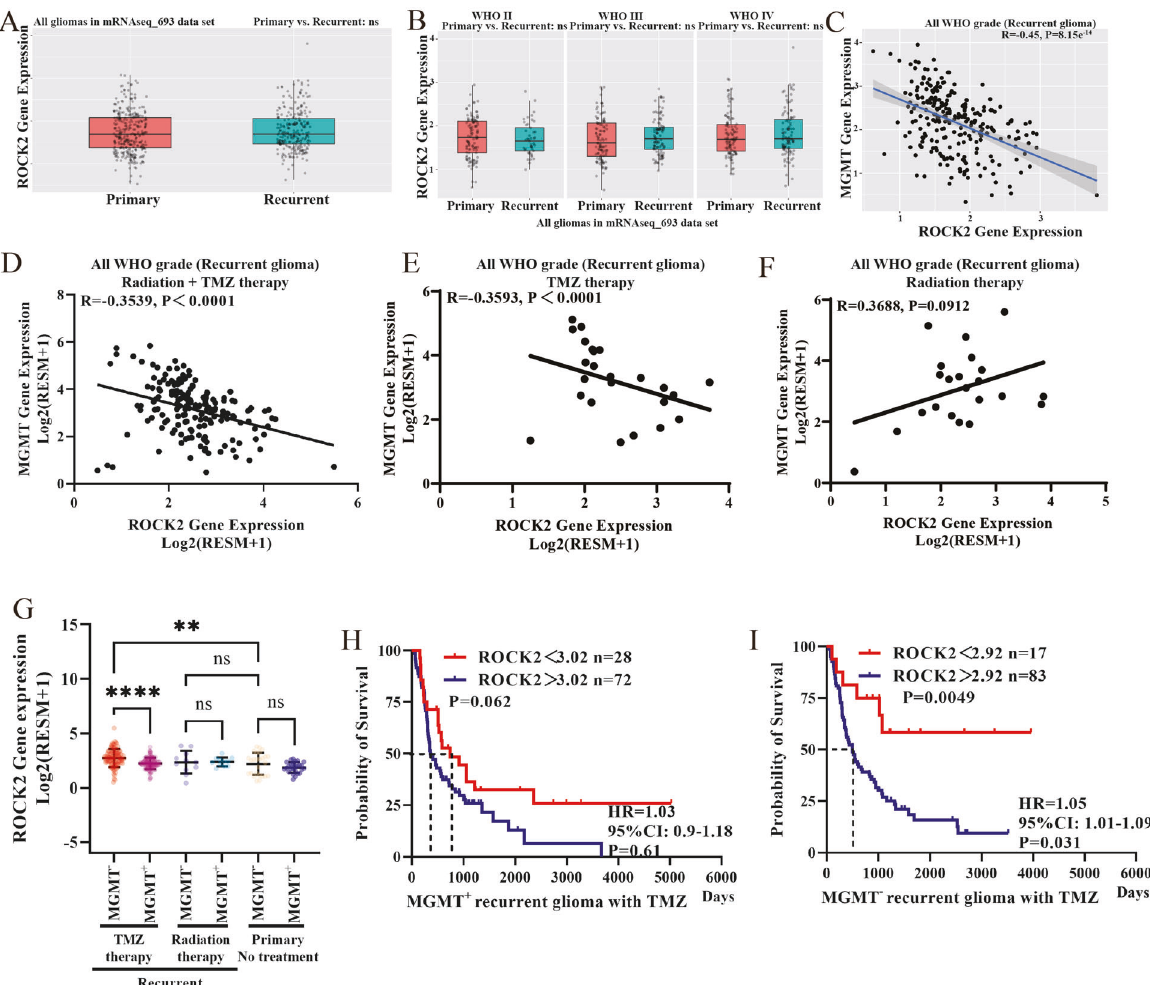
Fig. 1 Analysis of correlations between ROCK2, MGMT expressions and TMZ treatment responses in glioma patients in the CGGA database. A , B ROCK2 gene level in 693 case glioma patients as calculated by CGGA online tools. C Co-expression analysis of ROCK2 and MGMT mRNA expression in subset of recurrent gliomas. D Co-expression analysis of ROCK2 and MGMT mRNA expression in subset of recurrent gliomas with TMZ + Radiation therapy ( n = 168). E Co-expression analysis of ROCK2 and MGMT mRNA expression in subset of recurrent gliomas with TMZ treatment ( n = 24). F Co-expression analysis of ROCK2 and MGMT mRNA expression in subset of recurrent gliomas with radiation therapy ( n = 22). G ROCK2 mRNA expression levels in recurrent gliomas using mRNA 637 data set. Recurrent group: TMZ- treatment MGMT − ( n = 12), TMZ-treatment MGMT + ( n = 12), Radiation treatment MGMT − ( n = 11), Radiation treatment MGMT + ( n = 11), TMZ + Radiation treatment MGMT − ( n = 84), TMZ + Radiation treatment MGMT + ( n = 84). Primary group: without treatment, MGMT − ( n = 27), MGMT ( n = 26). H , I Survival analysis of recurrent MGMT high and MGMT low glioma patients with different ROCK2 expression. Statistical differences are given as * p < 0.05, ** p < 0.01, *** p < 0.005, **** p <